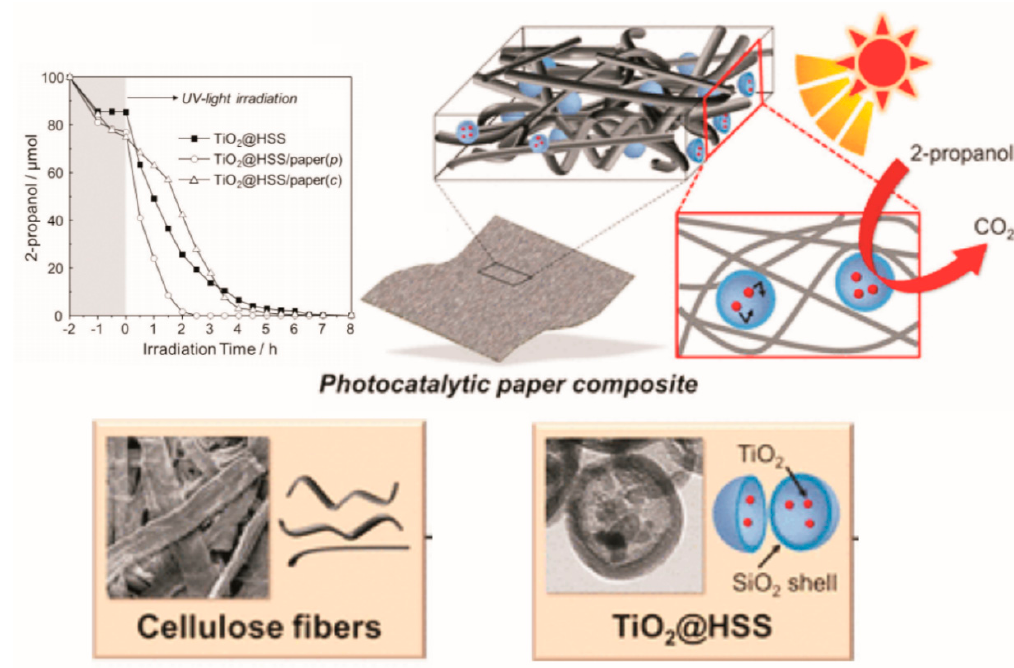
Figure 6. Photocatalytic degradation of 2-propanol and SEM images of paper fibers and the TiO 2 nanoparticles confined in hollow silica capsules (HSS) [55]. Reprinted with permission from fabrication of photocatalytic paper using TiO2 nanoparticles confined in hollow silica capsules, Langmuir 2017, 33, 1, 288–295. Copyright 2021 American Chemical Society.